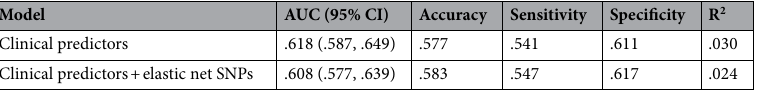
Table 3. Model performance for baseline features predicting distressing or intolerable side effects treatment outcome. Clinical predictors model includes sociodemographic and pre-treatment symptom variables only. The model in the second row adds the SNPs identified by the elastic net feature selection to the clinical predictors model. For threshold-dependent metrics (accuracy, sensitivity, specificity), a probability threshold of 0.5 was used for classification.